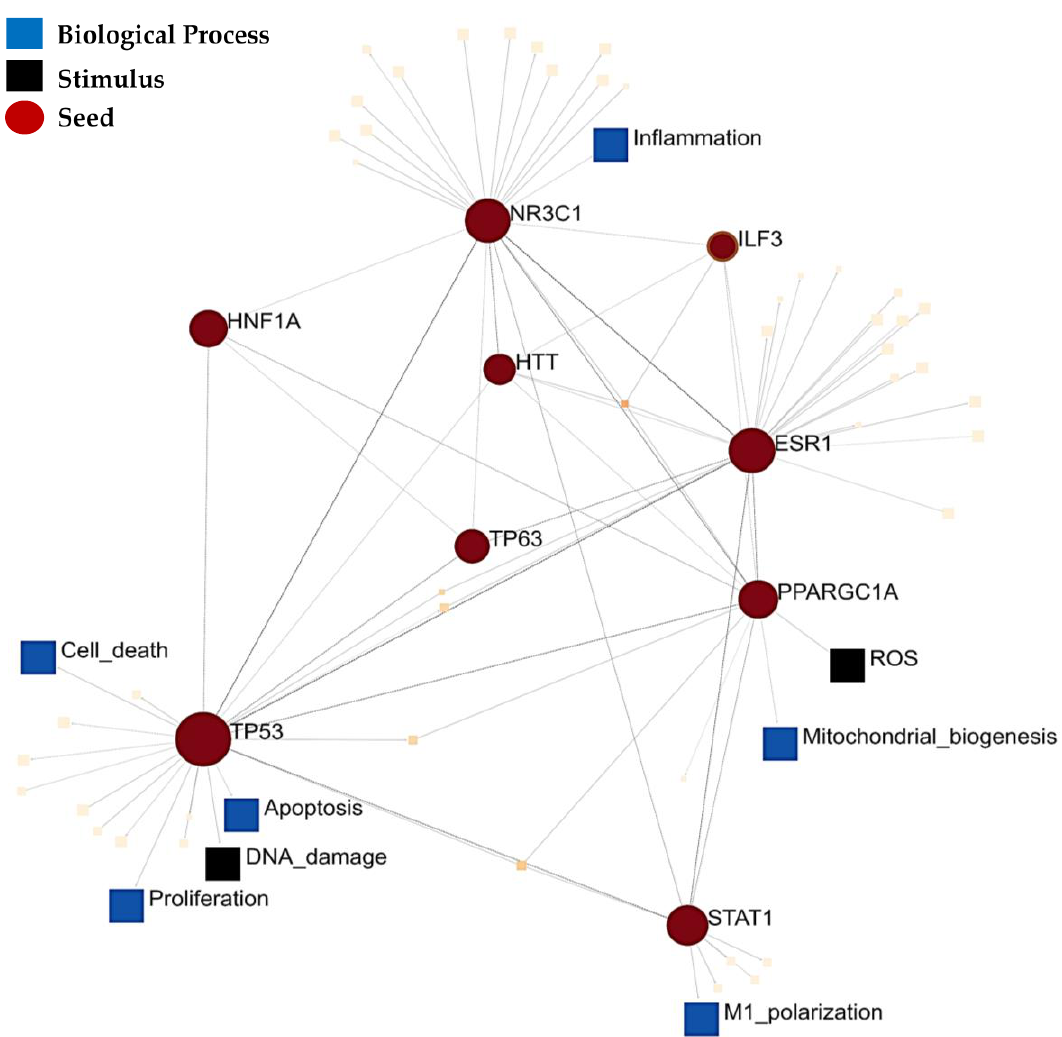
Figure 3. Signalling network between the top 10 transcription factor protein–protein interactions (PPI) enriched in the set of 121 proteins that are supported by ASD proteomic, transcriptomic, and epigenomic datasets. This PPI network was annotated with respect to signalling pathways in the SIGnaling Network Open Resource (SIGNOR) v2.0 database of manually annotated causal relationships between proteins that participate in signal transduction.